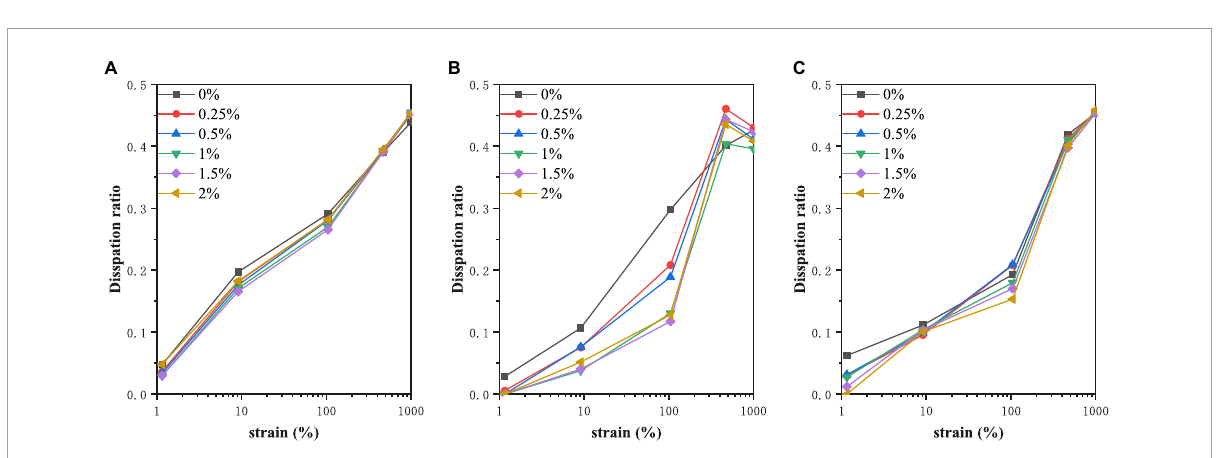
FIGURE6 Dissipation ratio of PPI with different TG concentrations at (A) 30 ◦ C, (B) from 30 to 120 ◦ C and (C) from 30 to 120 ◦ C and then cooled to 30 ◦ C.